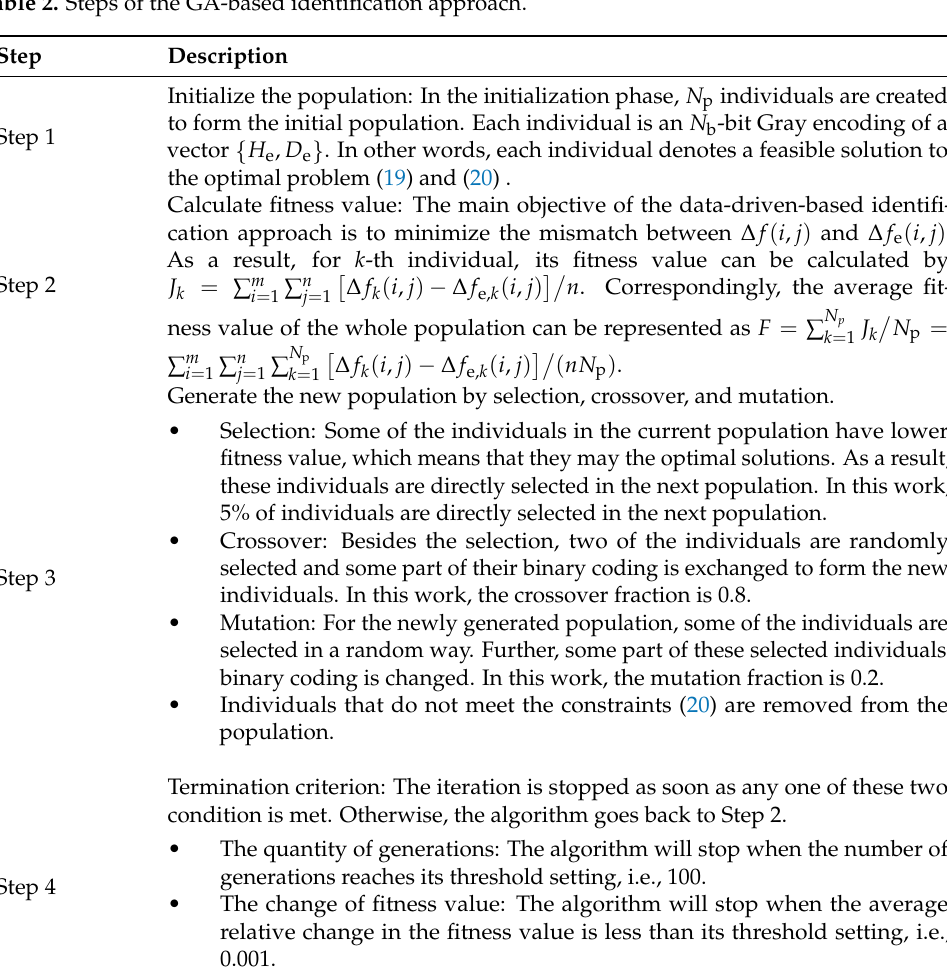
Table 2. Steps of the GA-based identification